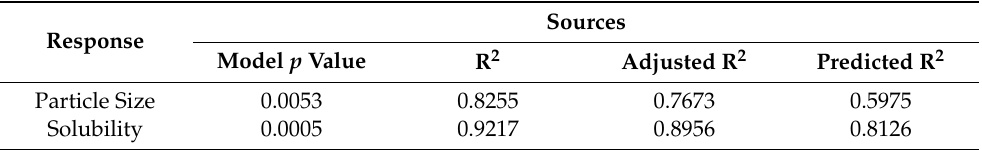
Table 6. Results of statistical analysis of the 3 2 full factorial experimental